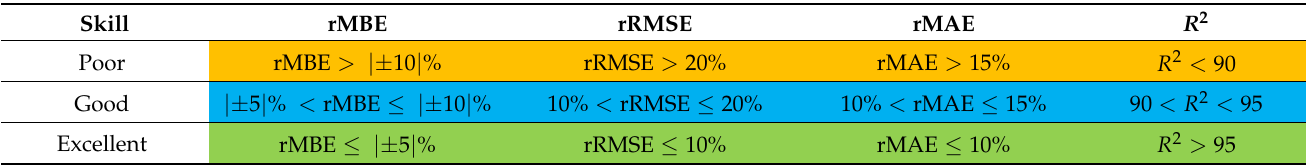
Table 5. Range of the statistical metrics used to benchmark the applicability of the gridded datasets. Green represents excellent performance, blue good performance, and orange poor performance).